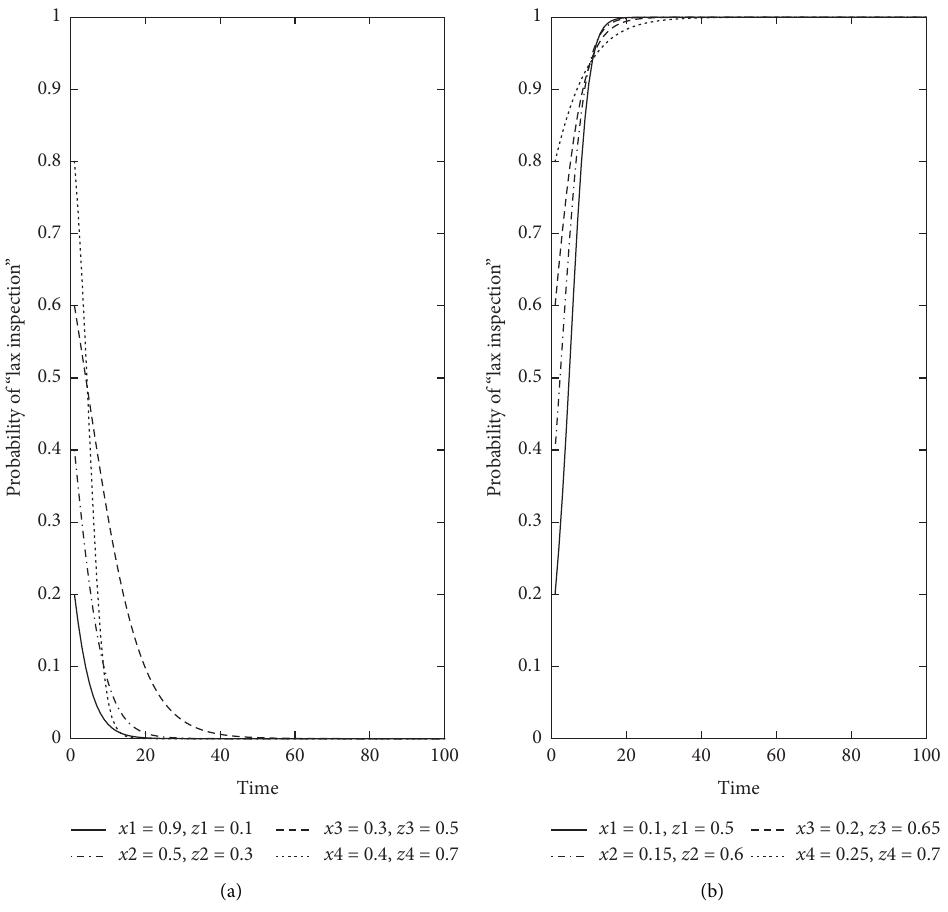
Figure 2: Evolutionary process of the compliance